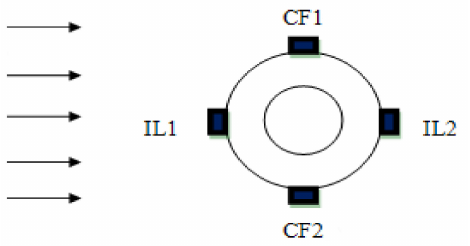
Figure 5. Four directions for the arrangement of the